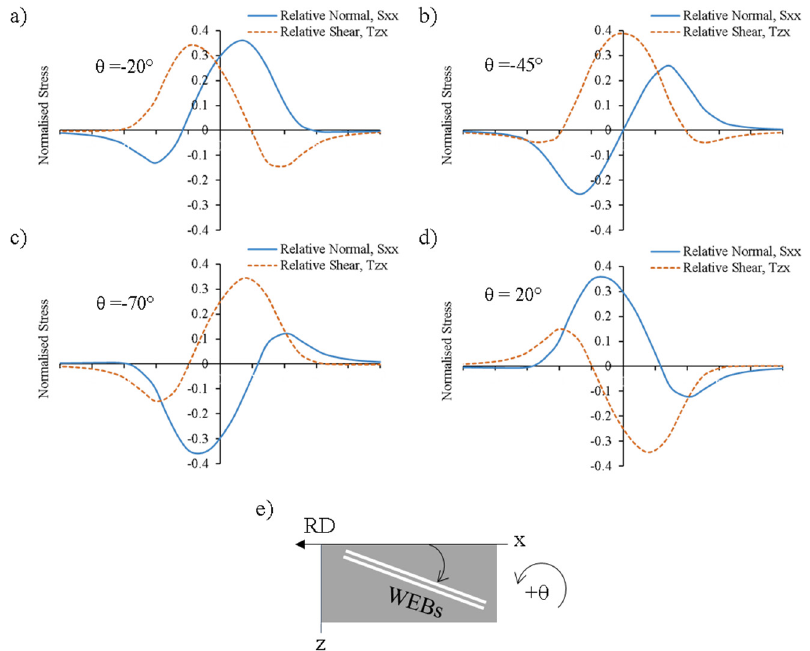
Figure 10. ( a – d ) Maximisation of relative normal stress and relative shear stress across various orientations (angle θ ) of WEBs; ( e ) represents schematic of WEBs orientation with rolling direction (RD) (adapted from [29] ) .